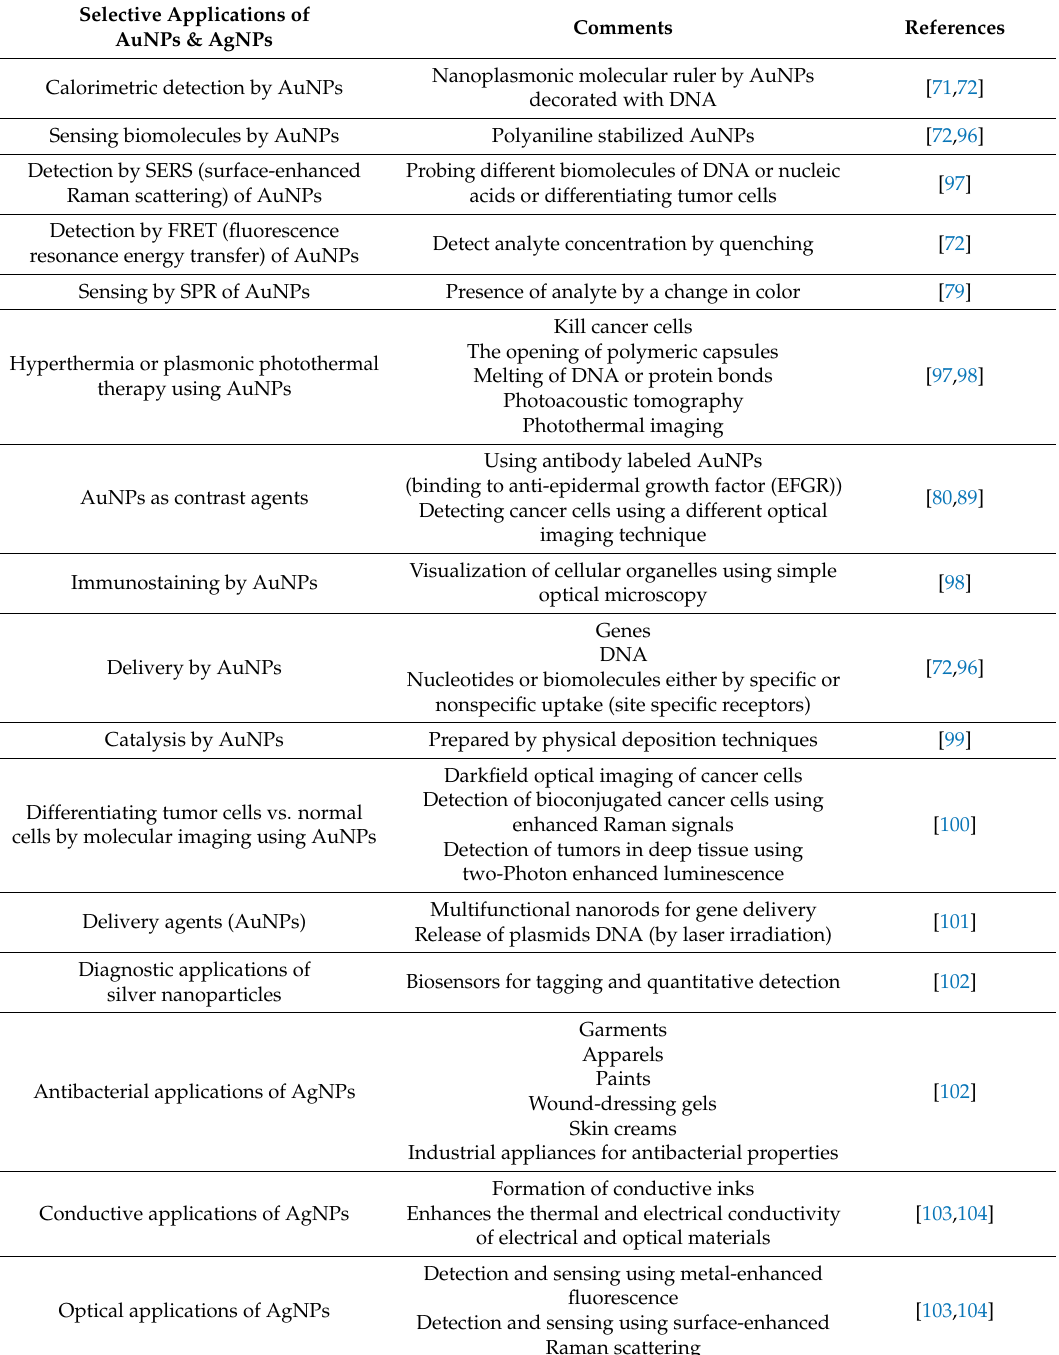
Table 2. Selective applications of gold (AuNPs) and silver (AgNPs) nanoparticles. Selective Applications of AuNPs &